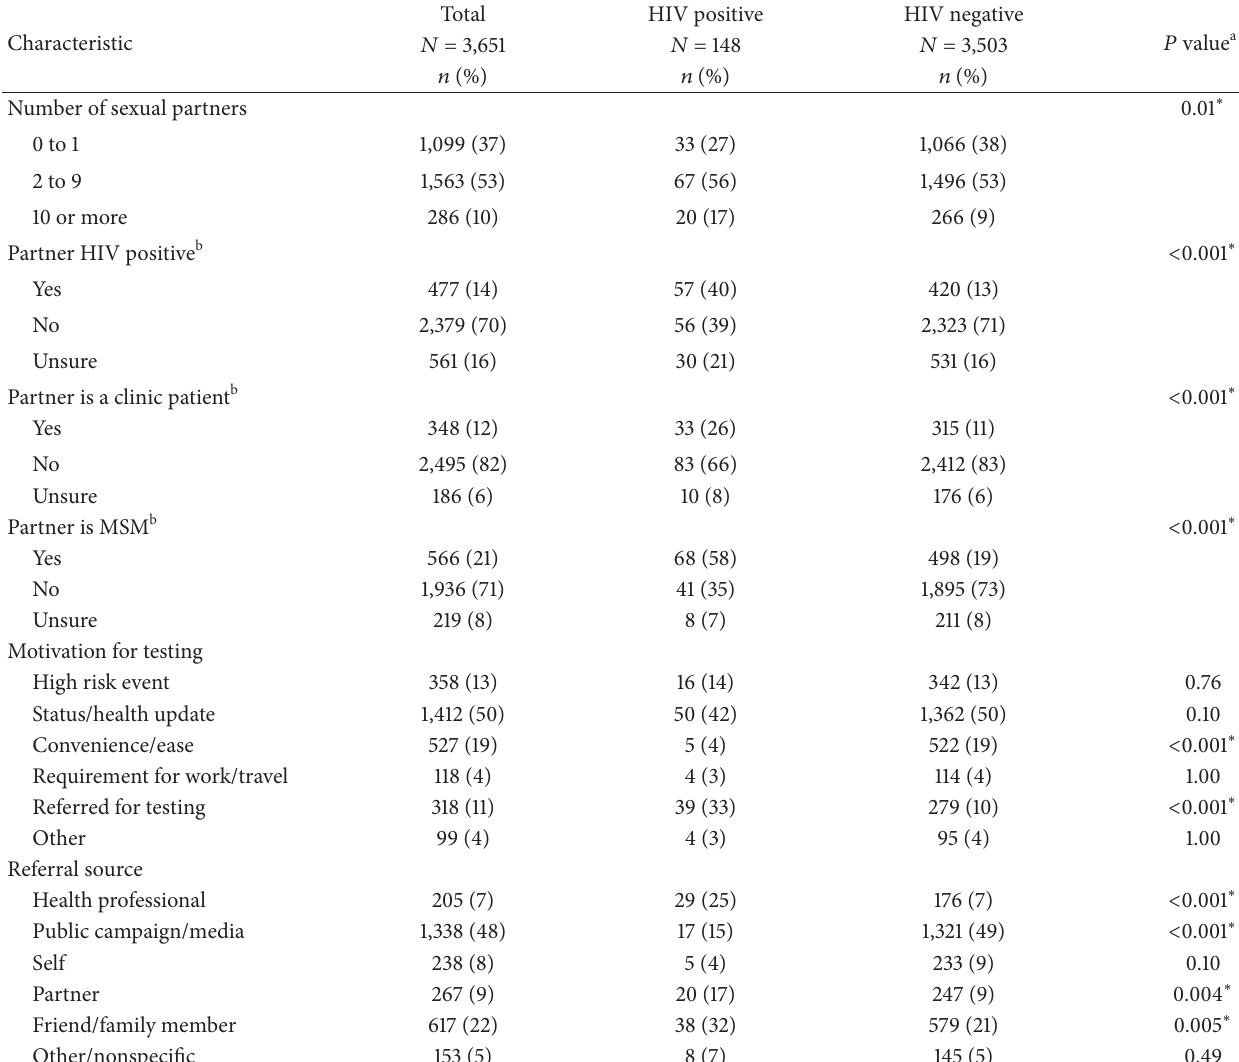
Table 4: Reported participant and partner characteristics of clients who presented for HIV POC testing by test result, AL, 2007–2012.